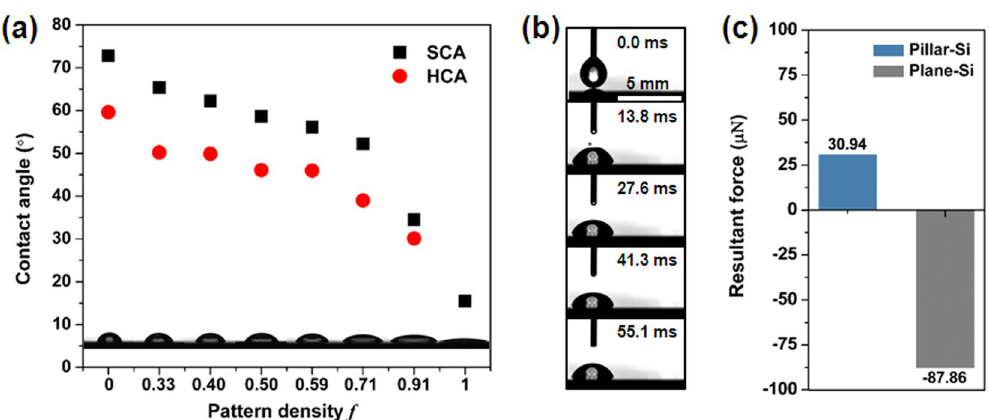
Figure 5. ( a ) The spatial variation of static contact angle (SCA) and the hysteresis contact angle (HCA) as a function of pattern density f for the surface without nanostructures. ( b ) Time-resolved images of a 7 μ L water droplets moving on plane-Si gradient stripes with λ = 0.83. ( c ) The comparison of resultant force of droplet on two types of surfaces. Pillar-Si surface has nanostructures around SiO 2 stripes. While on plane-Si surface, all the nanostructures are replaced by silicon